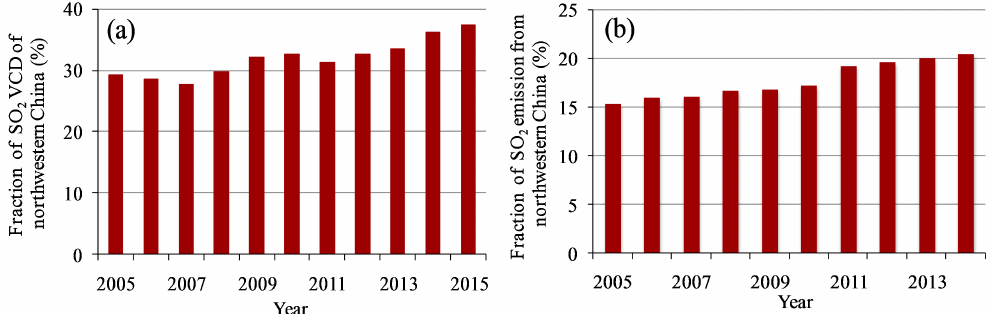
Figure 7. Annual fractions of OMI-retrieved SO 2 VCD and emissions averaged over 6 northwestern provinces in the national total SO 2 VCD from 2005 to 2015 and emissions from 2005 to 2014. (a) Fraction of annual mean SO 2 VCD; (b) fraction of annual mean emissions. Fractions of SO 2 VCD are calculated as the ratio of the sum of annually averaged SO 2 VCD in northwestern China to the sum of annually averaged SO 2 VCD in the national total from 2005 to 2015